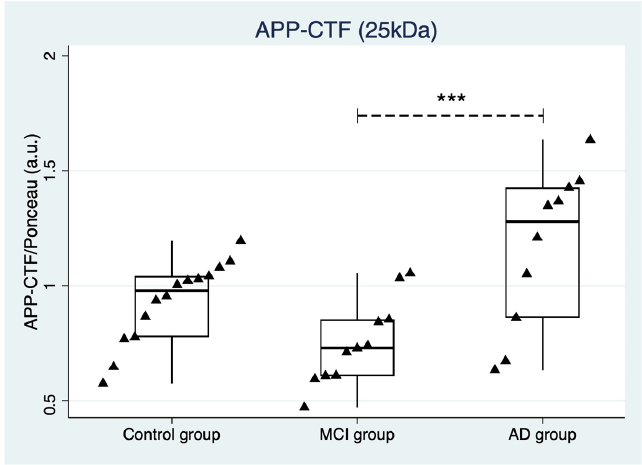
Figure 4. Strip plot showing the concentration of APP-CFT in the control group, in prodromal AD (MCI), and in mild-to-moderate AD. Boxes specify medians and quartiles, vertical spikes represent the largest or smallest value within the IQR of the upper or lower quartile. Three asterisks indicate p ≤ 0.001. MCI: mild cognitive impairment due to Alzheimer’s disease, AD: Alzheimer’s disease. Representative Western blot of p-tau and APP-CTF are shown in Figure 5a,b, respec- tively.